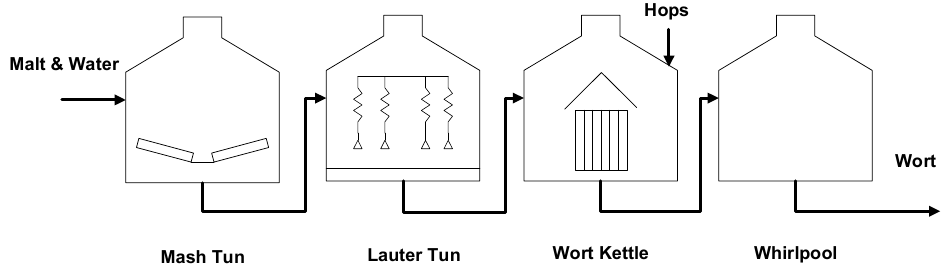
Figure 9. Traditional brewing process in the brewhouse.